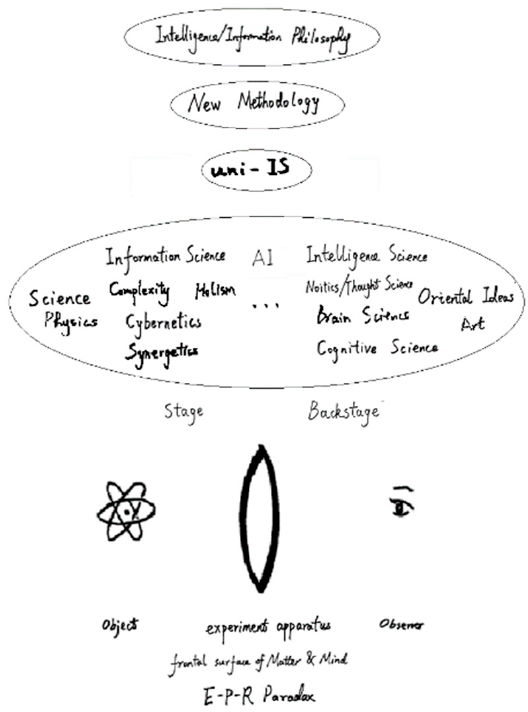
Figure 1. The study plan of intelligence science.